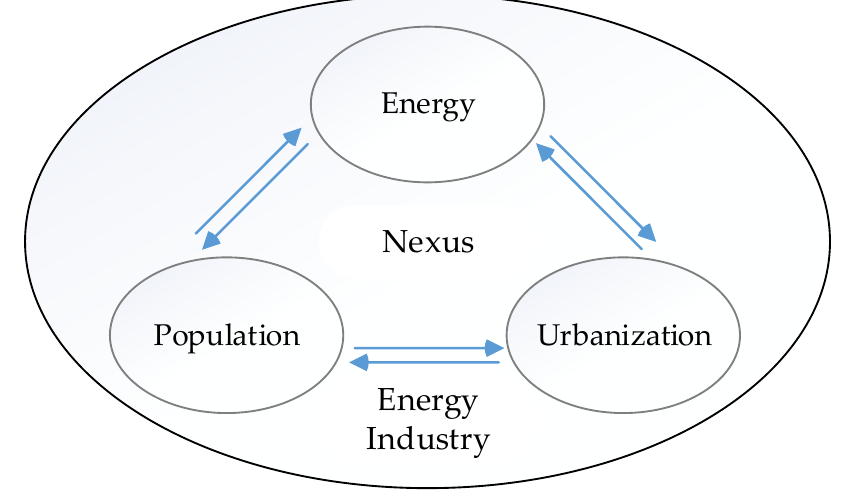
Figure 2. Energy – population – urbanization (EPU) nexus. Figure 2. Energy–population–urbanization (EPU)